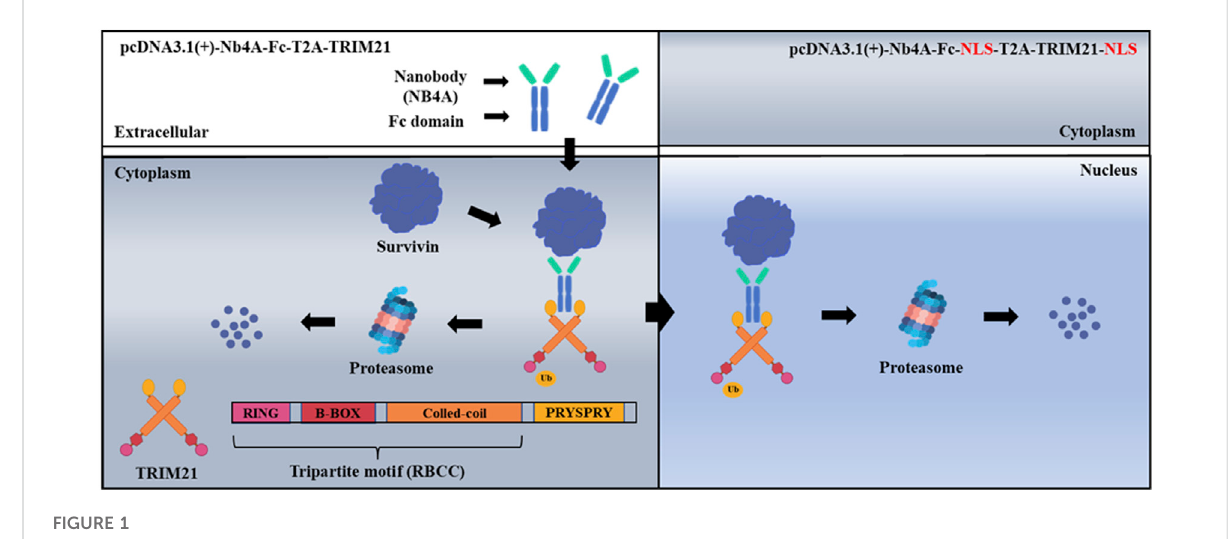
FIGURE 1 Schematic of ubiquitination targeting survivin in cancer cells. The nanobody Nb4A targets the survivin protein, and the PRYSPRY domain of the TRIM21 carboxyl-terminal binds speci fi cally to theFc fragment of thefusion protein NB4A-Fc, which leads to a large amount ofsurvivin degradation of cytoplasmic survivin with nuclear survivin via the